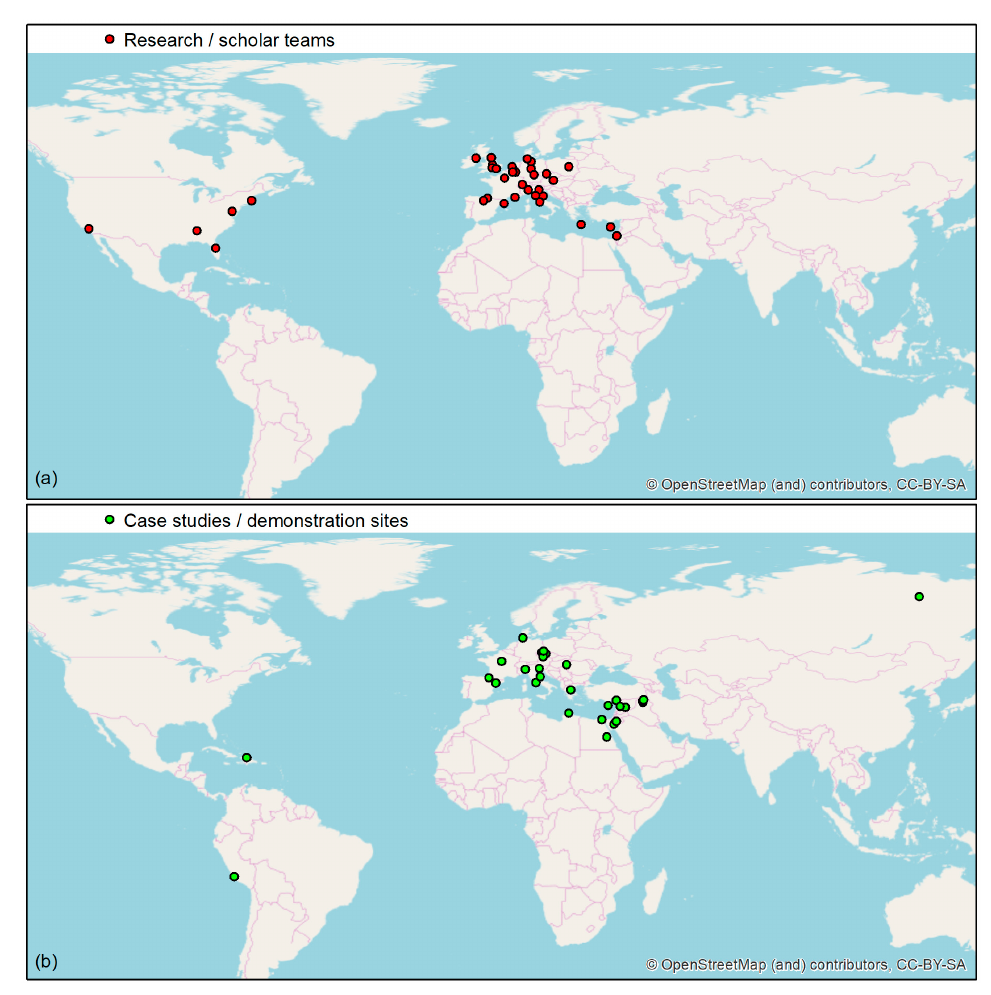
Figure 1. Geographic distribution of: ( a ) authors and research teams publishing in the Special Issue; ( b ) case studies and demonstration sites that are discussed in the papers.